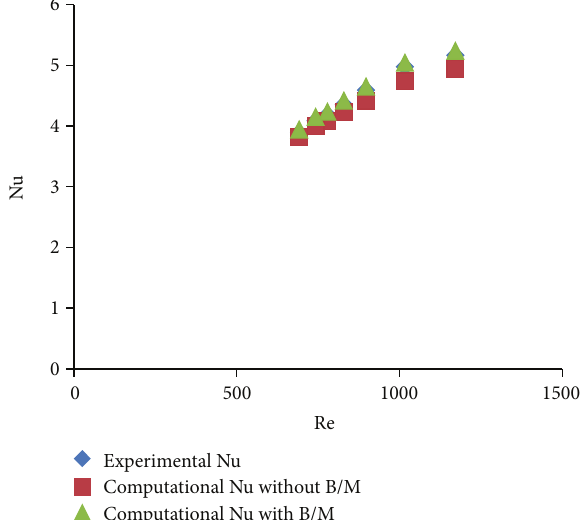
Figure 4: Nusselt number versus Reynolds number for 0.87 mm ID- tube and 3% Al 2 O 3 -water nanofluid.